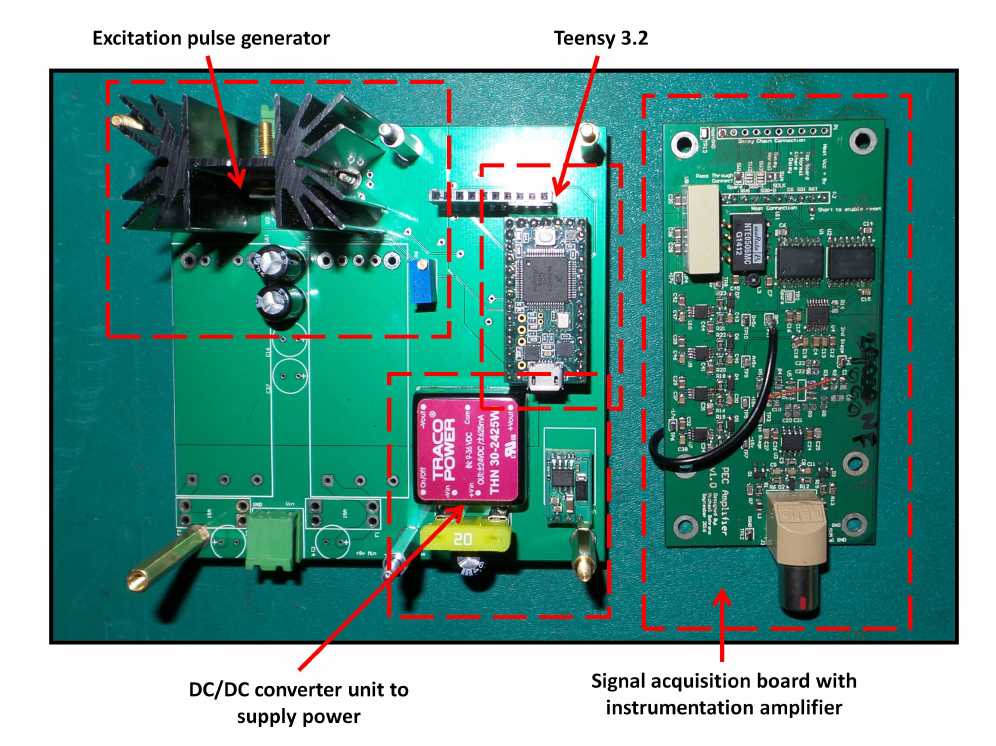
Figure 10. Fabricated PCB for sensor excitation and signal